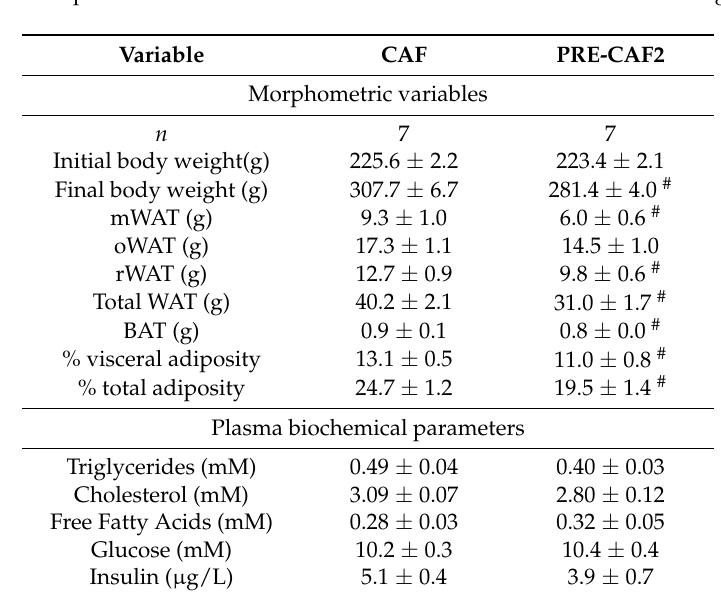
Table 3. Morphometric and biochemical characteristics of the short treatment